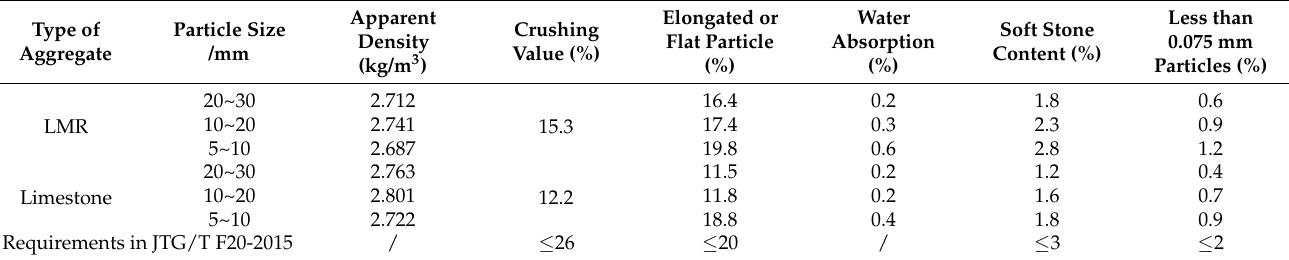
Table 4. The physical properties of LMR coarse aggregate.